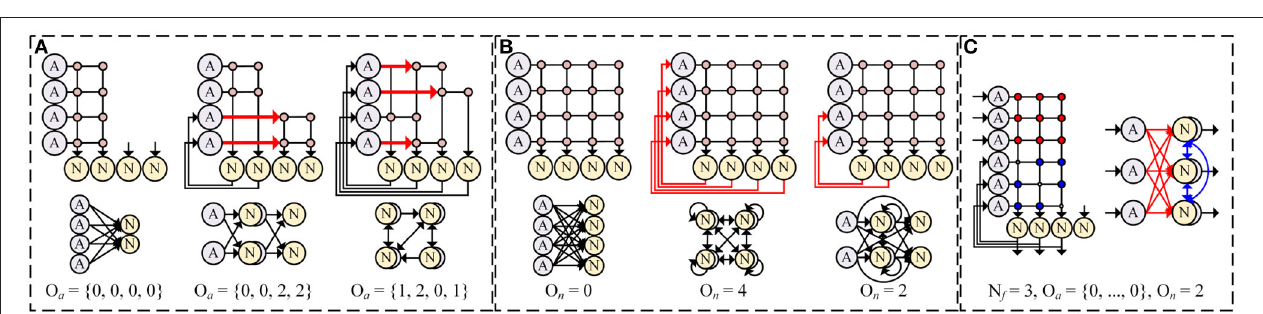
FIGURE 6 | Network compositions with (A) different axonal offsets ( N f = 2) and (B) different neuronal offsets ( N f = 4), and (C) an example of implemented lateral inhibitory layer ( N f =